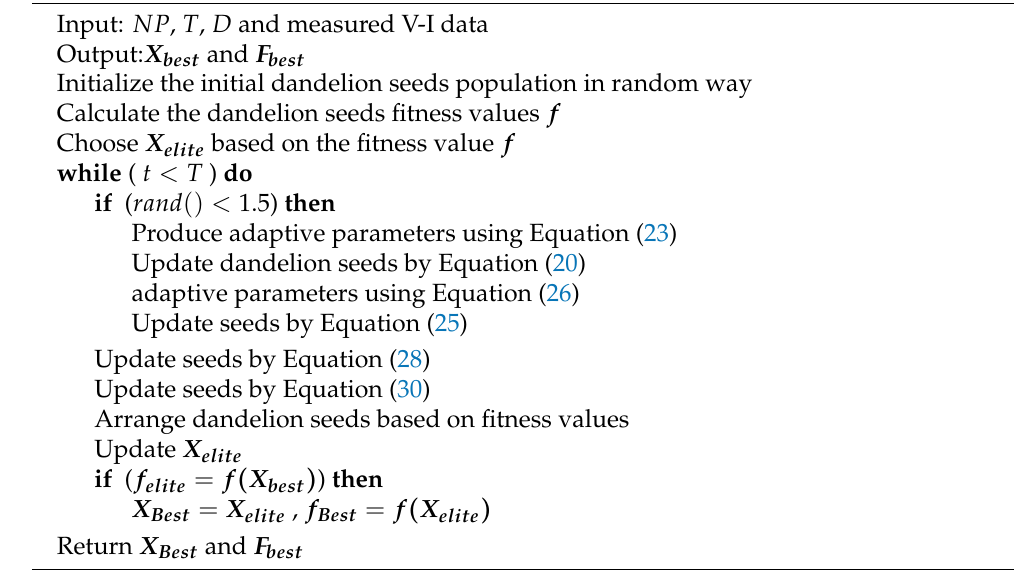
Algorithm 1 Pseudo-code of the proposed DO optimizer